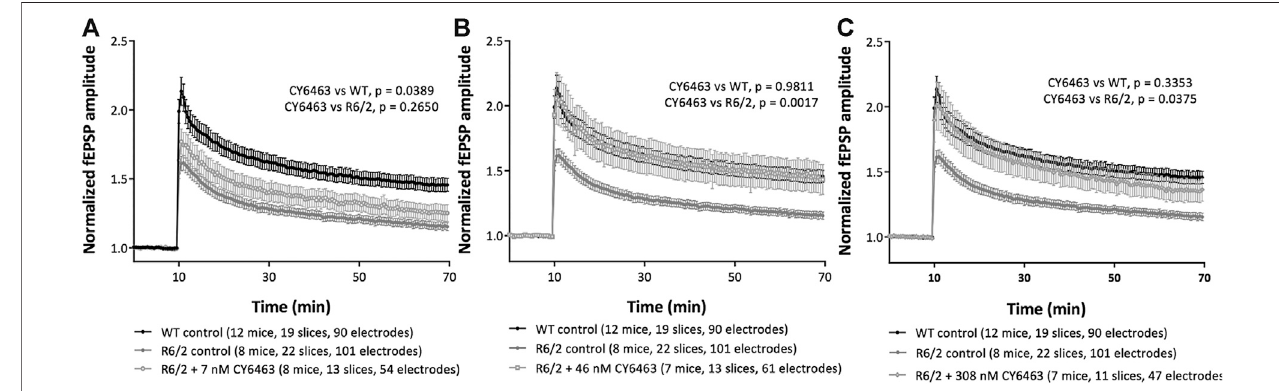
FIGURE 6 | LTP in R6/2 Huntington ’ s mouse model. Mouse hippocampal slices in control conditions or after exposure to (A) 7 nM CY6463, (B) 46 nM CY6463, (C) 308 nM CY6463, and in wild-type (WT) mice hippocampal slices. The mean value of fEPSP amplitude is plotted ± SEM vs. time. The entire recording time is displayed,but only datafromthelast 20 minoftherecordingperiod wereanalyzed using Repeated Measures two-way ANOVA without Geisser-Greenhousecorrection followed by an uncorrected Fisher ’ s LSD comparing all groups to each other. p values are noted in fi gure legends.